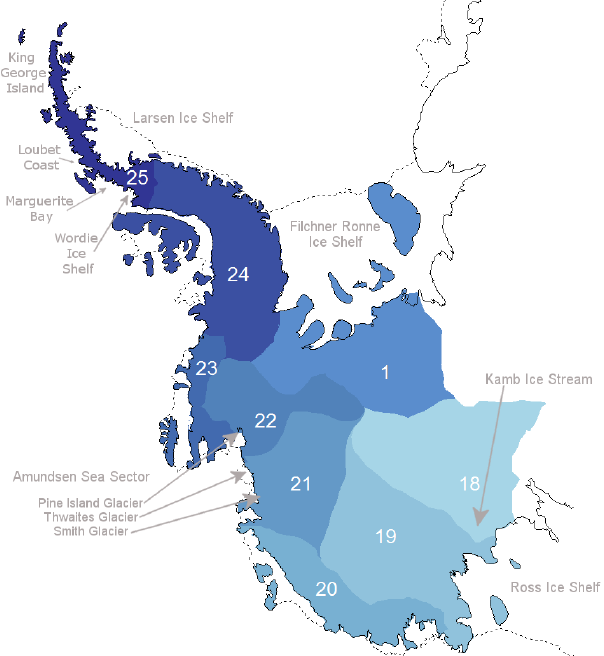
Figure 7. Basin definitions used for West Antarctica (adapted from Sasgen et al., 2013).